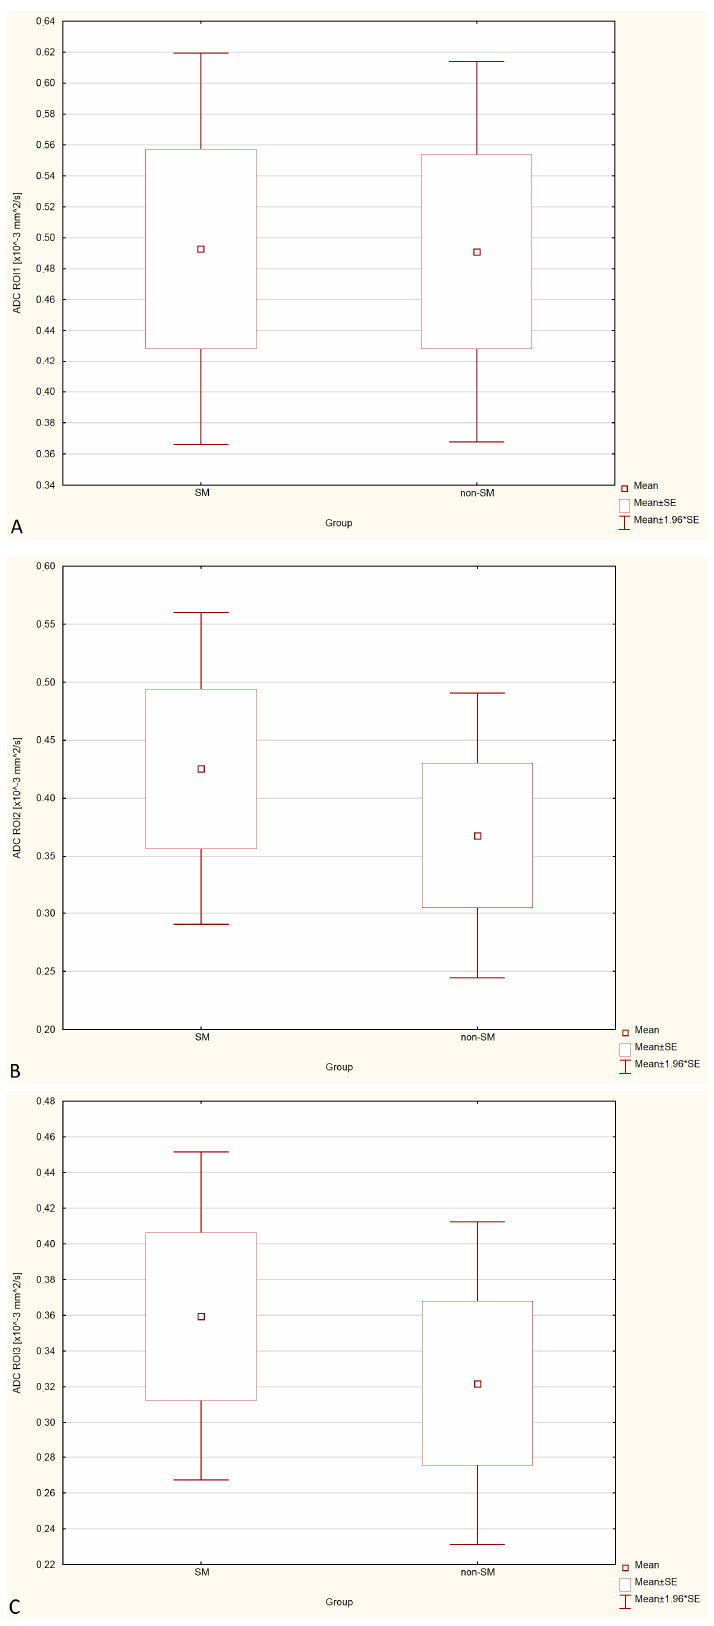
Figure 3. Boxplots comparing FA values in ROI-1 ( A ), ROI-2 ( B ), ROI-3 ( C ) between the SM and non-SM groups.